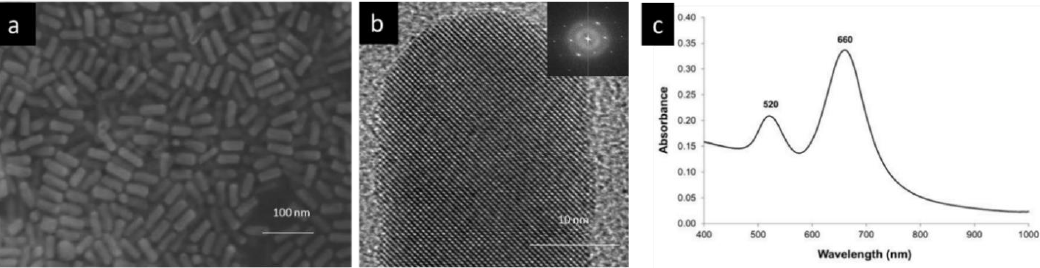
Figure 5. ( a ) SEM image, ( b ) HRTEM image — inset electron diffraction, and ( c ) UV-Vis spectrum of AuNRs.